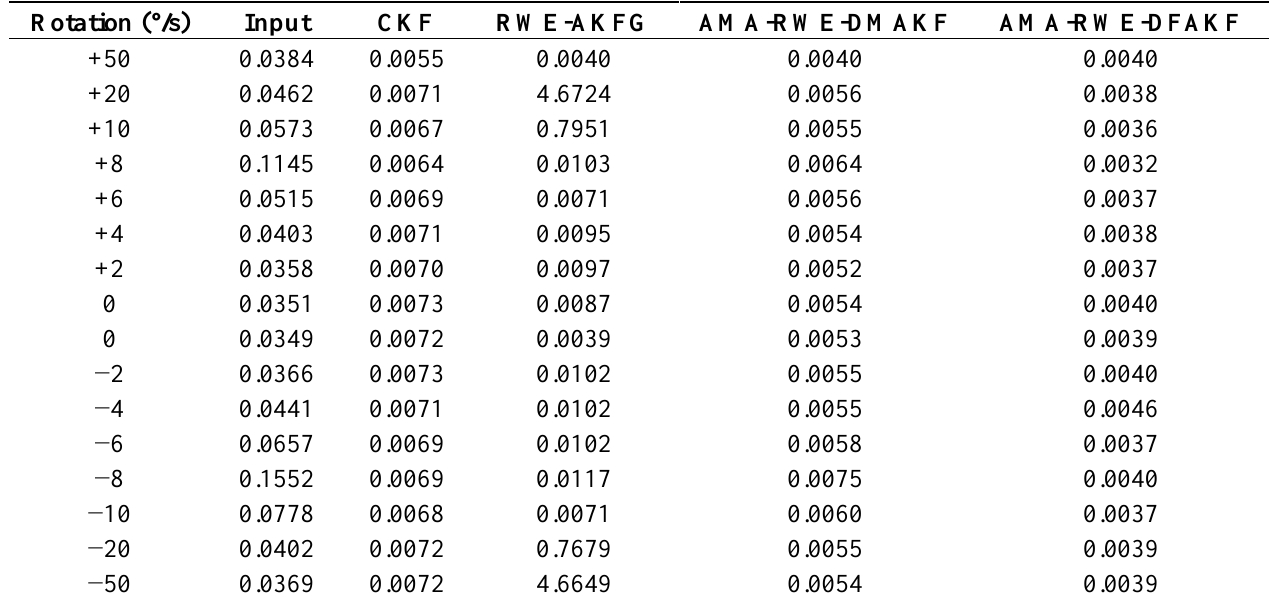
Table 2. RMSE results of ±50°/s FOG signal with sampling 100 HZ.